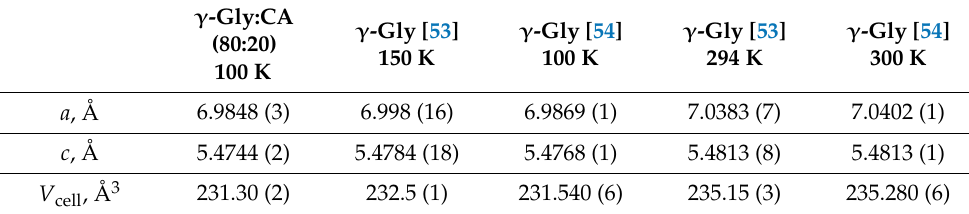
Table 3. Comparison of unit cell parameters a , c , and unit cell volume V cell in γ -Gly:CA (80:20) and nominally pure γ -Gly crystals from